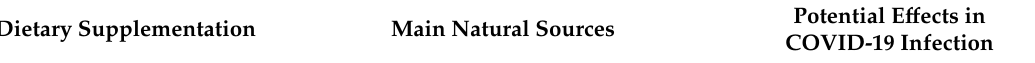
Table 1. The principal antioxidants involved in lung infection and the immune-inflammatory response. Dietary